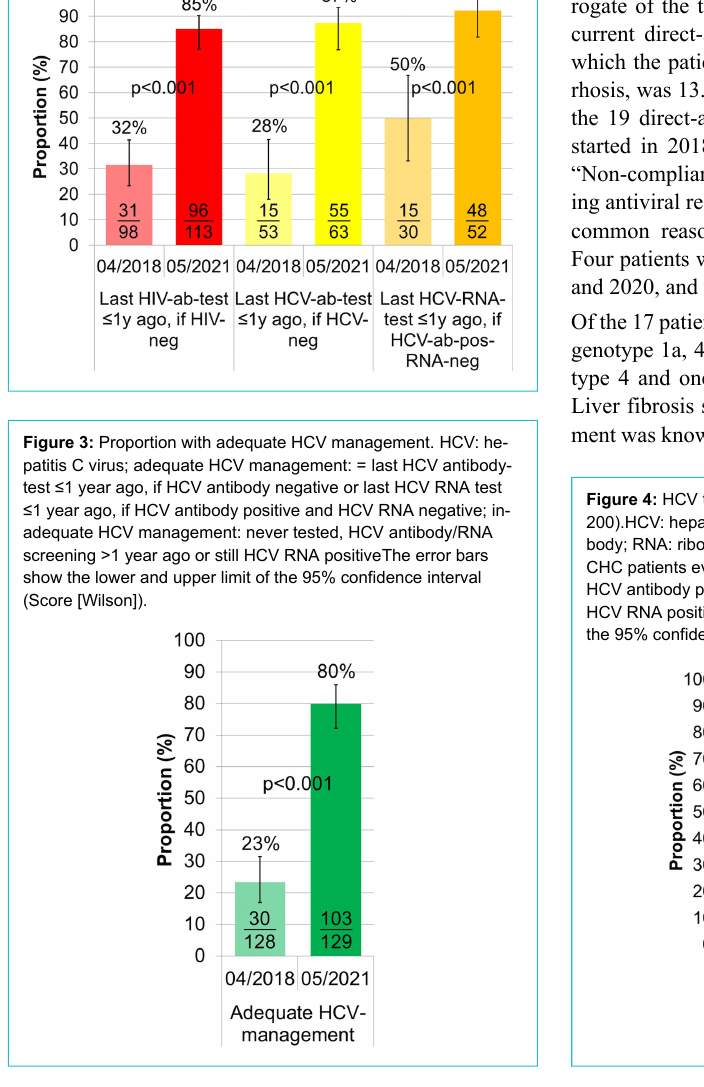
Figure 2: Proportion of HIV/HCV negative patients recently tested for HIV/HCV antibodies and proportion of HCV antibody positive and RNA negative patients recently tested for HCV RNA(i.e., ≤1 year ago). HCV: = hepatitis C virus; HIV: human immunodeficiency virus; ab = antibody; RNA: ribonucleic acid, y: yearThe error bars show the lower and upper limit of the 95% confidence interval (Score [Wilson]).